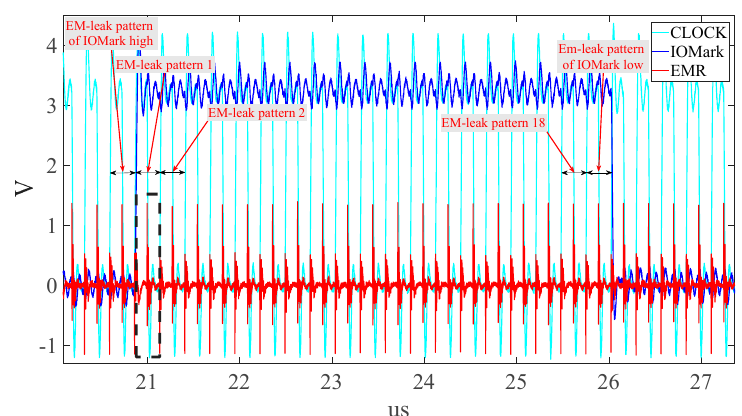
Figure 12. TestKernelEMR (EMR within IOMark) from Figure 11.